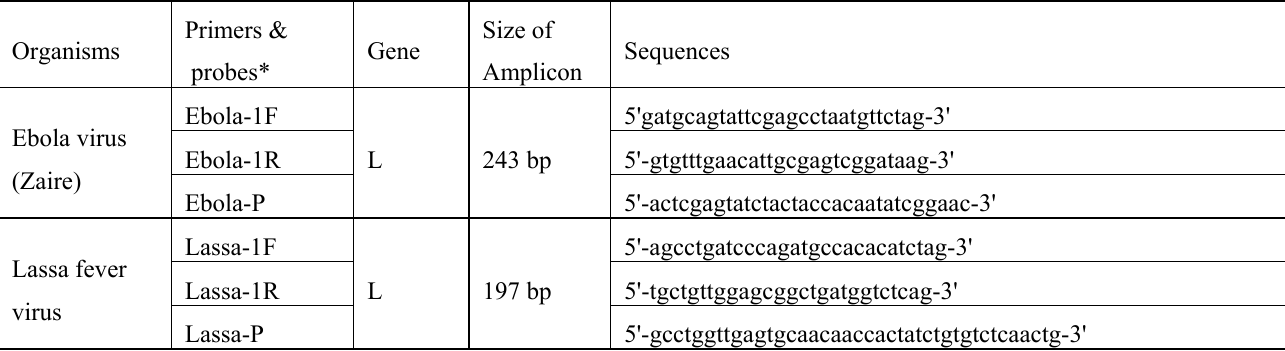
Table 5B. Primer and probe sequence using in the BioT RNA multiplex RT-PCR-EHA